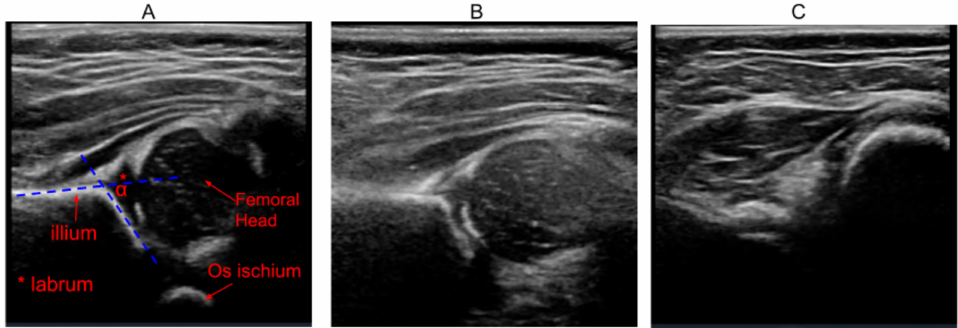
Figure 1. Examples of ultrasound hip images of different scan quality. ( A ) Example of a high- quality image in which all landmarks such as ilium, os ischium, labrum and femoral head are clearly visible. The alpha angle is measured as the inner angle between the iliac line and acetabular roof. ( B ) Moderate-quality scan containing all landmarks, but with the blurring of the os ischium and blurring and slight tilt of the iliac line. ( C ) Poor-quality image with none of the landmarks visible.